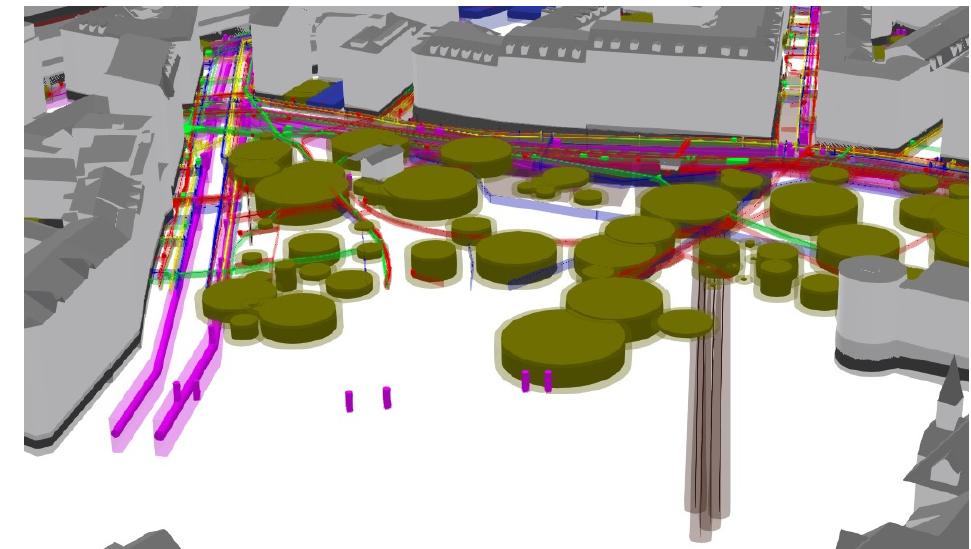
Figure 14. Three-dimensional view of underground volumes, developed [26]. Table 3 indicates colors applied to the different objects, based on Swiss construction